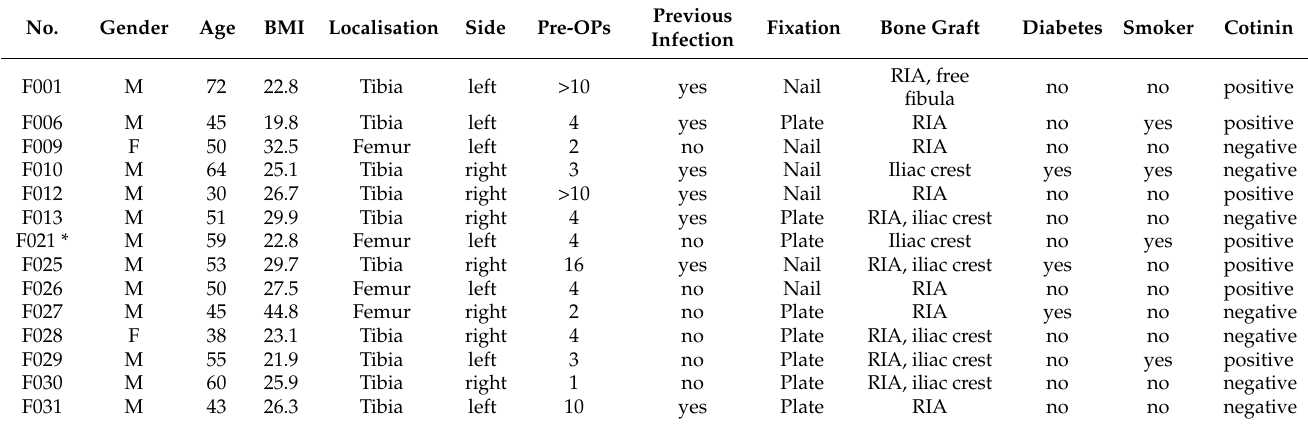
Table 1. Study Group Responder.